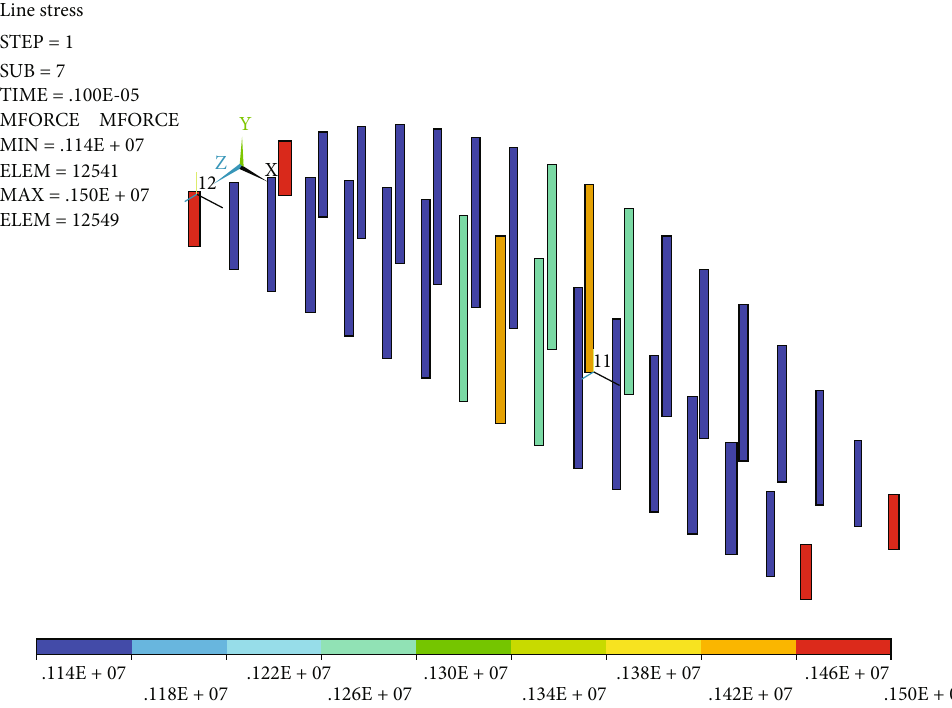
Figure 9: The axial force cloud map of hanger under case 7